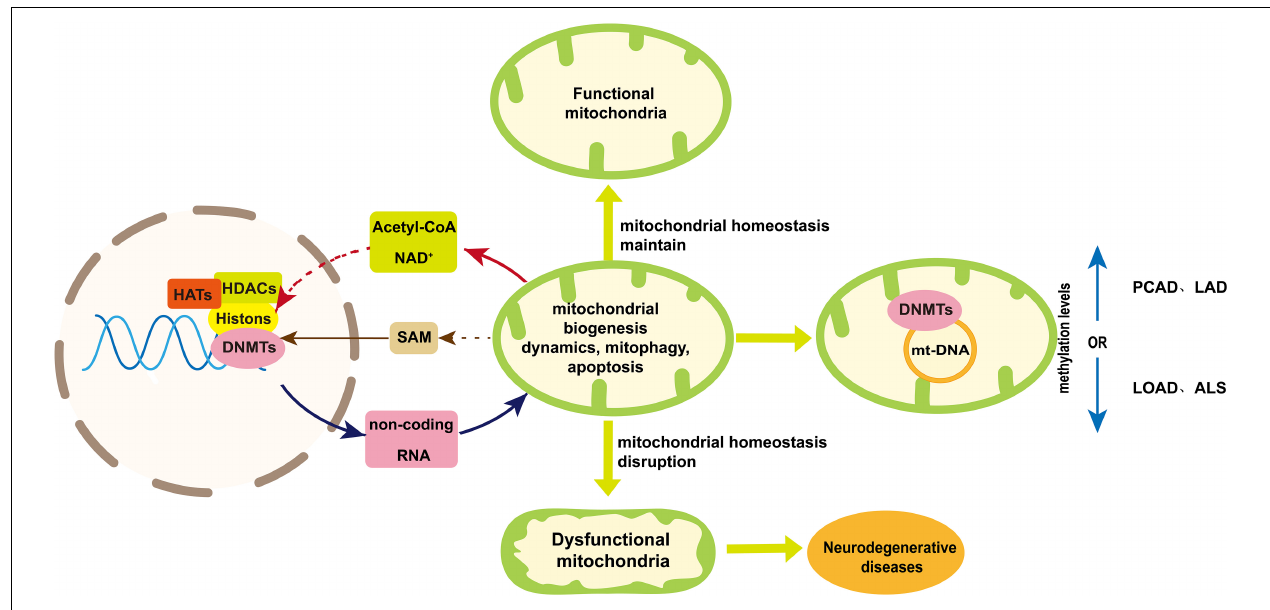
FIGURE 4 | A schematic diagram of mtDNA methylation and the bidirectional communication between mitochondria and nuclear in epigenetic regulation. Mitochondria maintain their homeostasis in several ways including mitochondrial biogenesis, dynamic, mitophagy and apoptosis. Disruption of mitochondrial homeostasis will result in impaired mitochondrial function, which may contribute to neurodegenerative diseases. Mitochondria are involved in the epigenetic regulation from two aspects. One is mtDNA methylation, the extent of which varies among neurodegenerative diseases. The other is the bidirectional communication between mitochondria and nuclear, which is essential to maintain mitochondria homeostasis and can play a role in nuclear epigenetic regulation of neurogenerative diseases. Acetyl-CoA and NAD + provided by mitochondria indirectly play a role in histone acetylation and deacetylation, respectively, to influencing